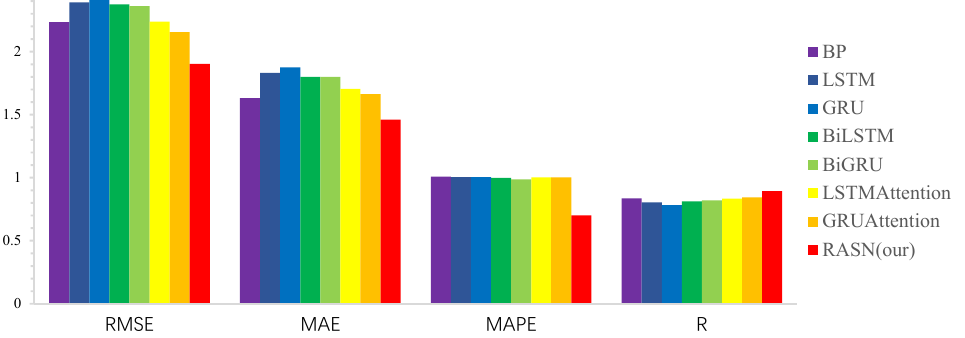
Figure 6. Comparison of experimental evaluation indicators for temperature prediction.